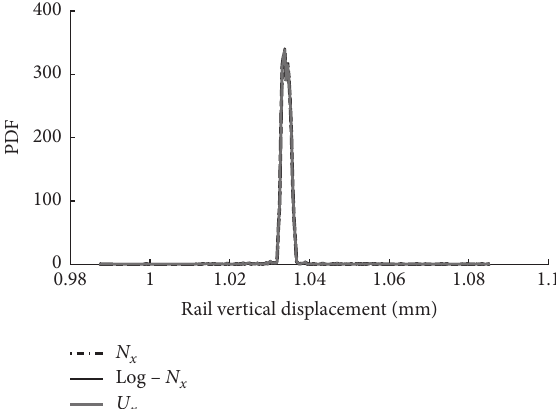
Figure 10: The influence of longitudinal distribution of rail pad lateral stiffness on the distribution of the rail vertical